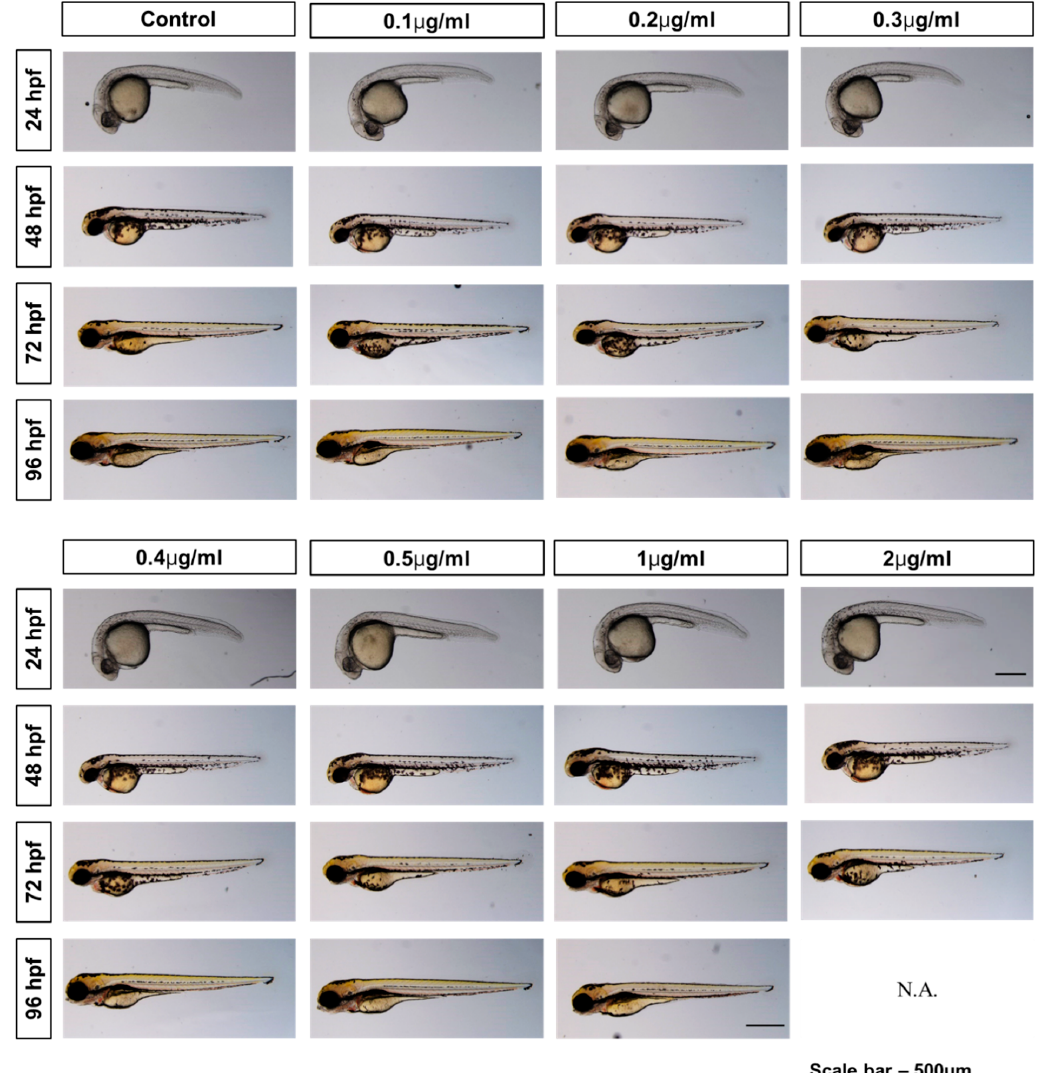
Figure 2. Morphological images of zebrafish embryos/larvae during embryogenesis under 0 to 2 mg/L PHMG-P exposure. N.A.: not available due to significant lethality.